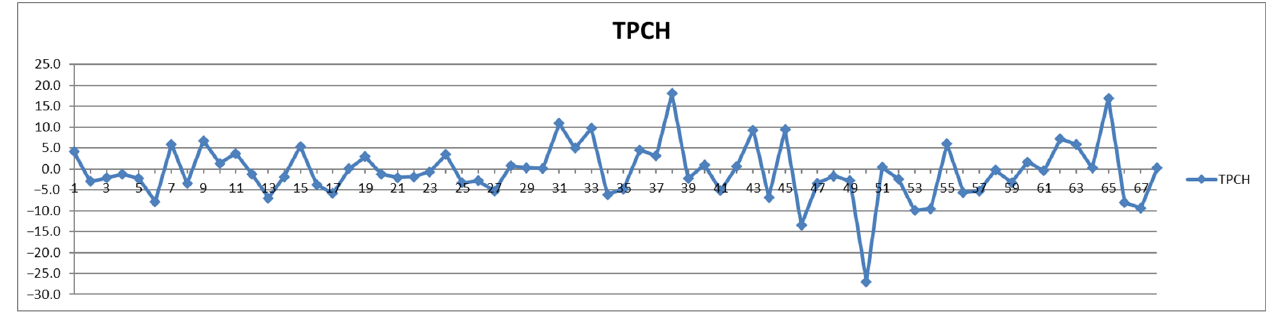
and fasting concentrations as percentage relative to fasting concentration.